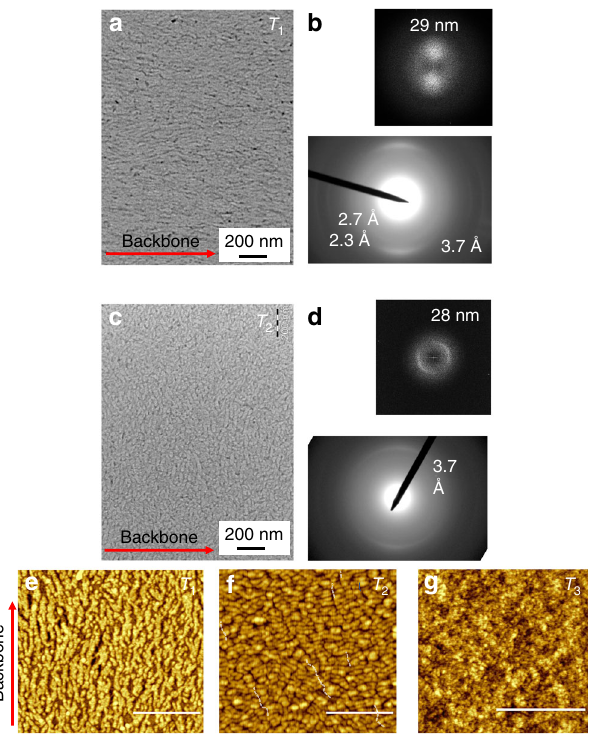
Fig. 3 Microscopic characterization. TEM analysis and electron diffraction of T 1 ( a , b ) and T 2 ( c , d ) annealed fi lms; e – g AFM topography images